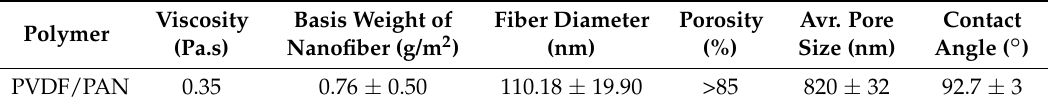
Figure 4. SEM images of PVDF/PAN nanofibers after the lamination process. Table 2. Membrane characterization for PVDF/PAN nanofibers.